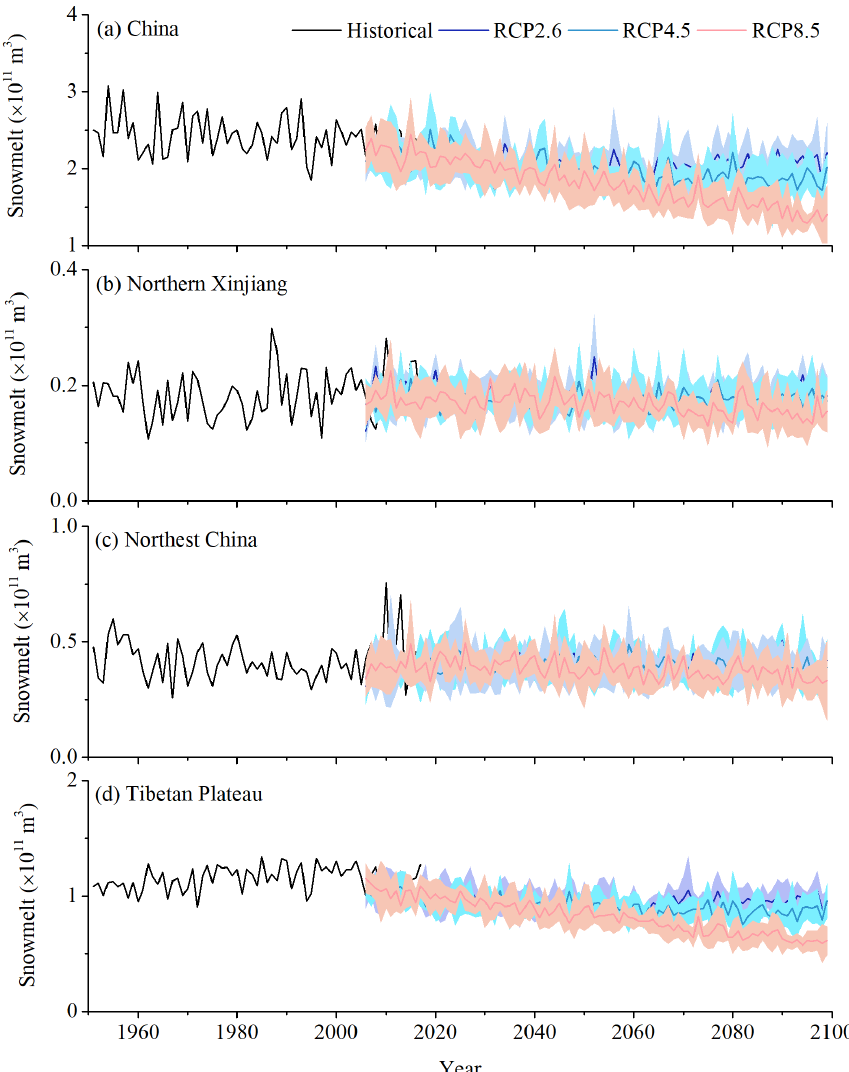
Figure 12. Projected future changes in snowmelt in China and its three main stable snow cover regions. The historical period is 1951–2017, and RCP is the representative concentration